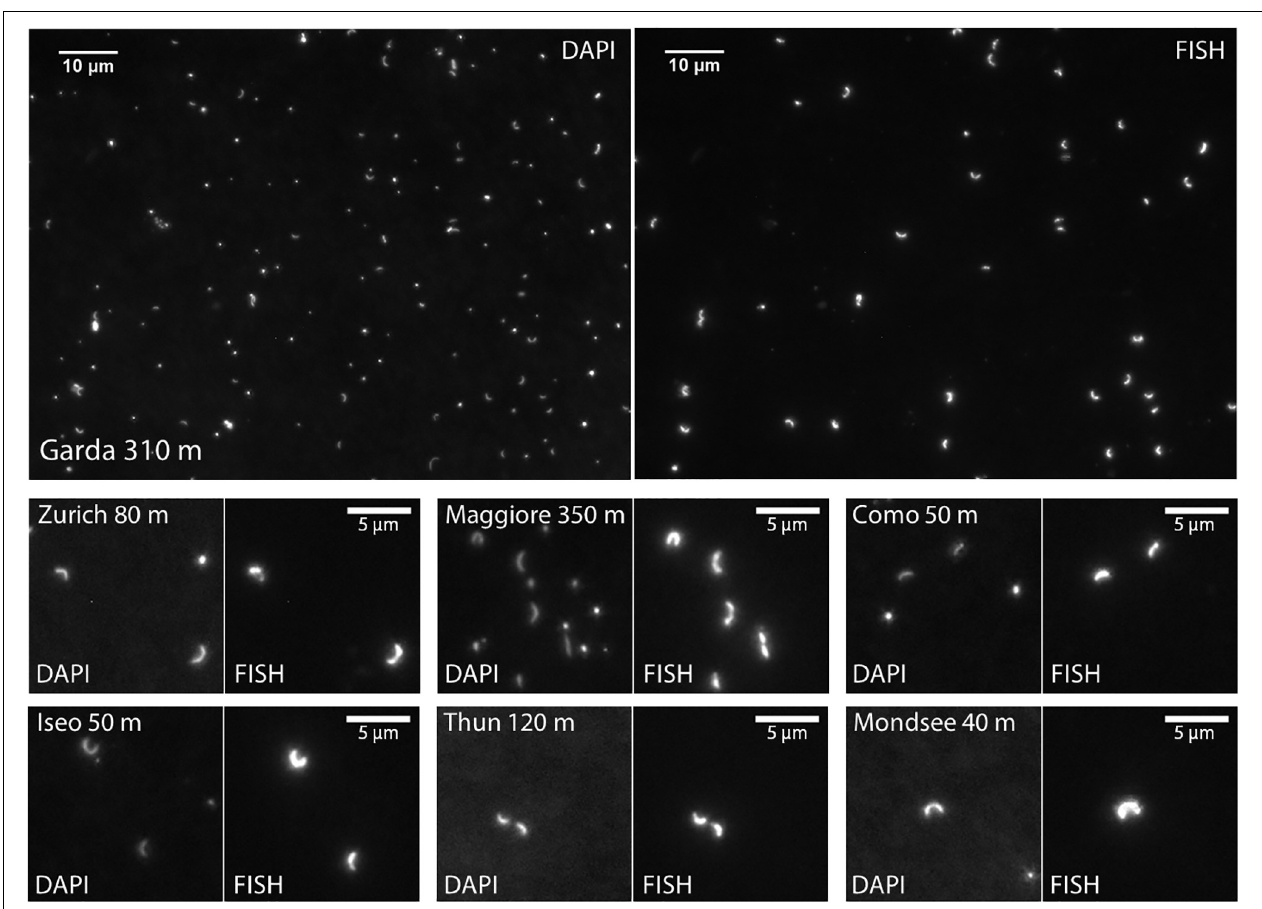
FIGURE 3 | Microscopic images of CL500-11 cells detected by CARD-FISH. In each panel, DAPI-stained cells and the corresponding FISH-positives were shown in the left and right side, respectively. A whole microscopic field was shown for the sample taken from 310 m in Lake Garda, where the highest proportion of CL500-11 cells was recorded. For the other lakes, enlarged images were shown. The samples taken on December were used for the images from Lake Zurich and